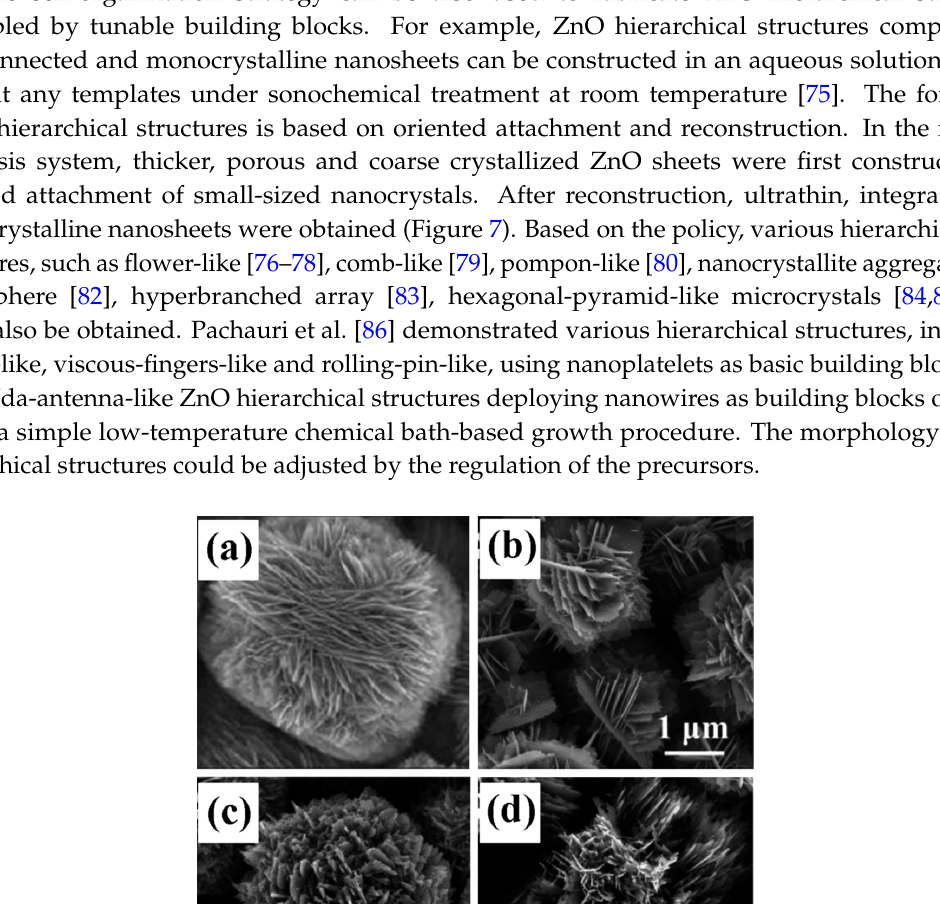
Figure 7. SEM images of different hierarchical ZnO structures. ( a – d ) (Reproduced with permission from [75], Copyright 2013, American Chemical Society).